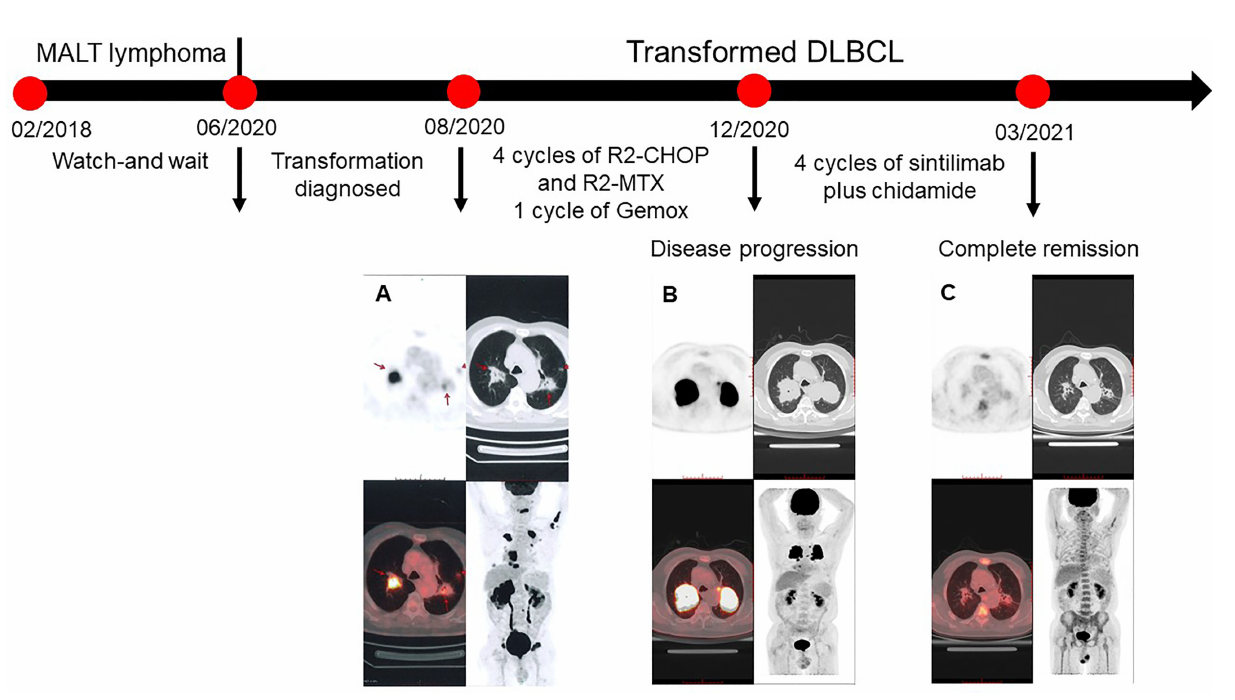
FIGURE 1 | PET/CT scans of the patient. (A) Baseline. The fl uorodeoxyglucose (FDG) uptakes increased in multiple patchy shadows and massive consolidations of the bilateral lungs (SUVmax = 22.1), multiple partial bones (SUVmax = 19), multiple swelling lumbosacral nerve roots (SUVmax = 16), masses in the bilateral adrenal glands (SUVmax = 31.2), and a nodule (0.7 cm) between cervical rear muscles. (B) Disease progression after fi rst-line chemotherapy. The sizes and FDG uptakes of massive consolidations in the bilateral lungs increased with SUVmax of 31.5. FDG uptakes of other lesions decreased. (C) The patient achieved a complete response after four cycles of sitilimab and chidamide. The SUVmax of lesions in the left and right lungs were 2.4 and 2.1, which indicated a Deauville score of